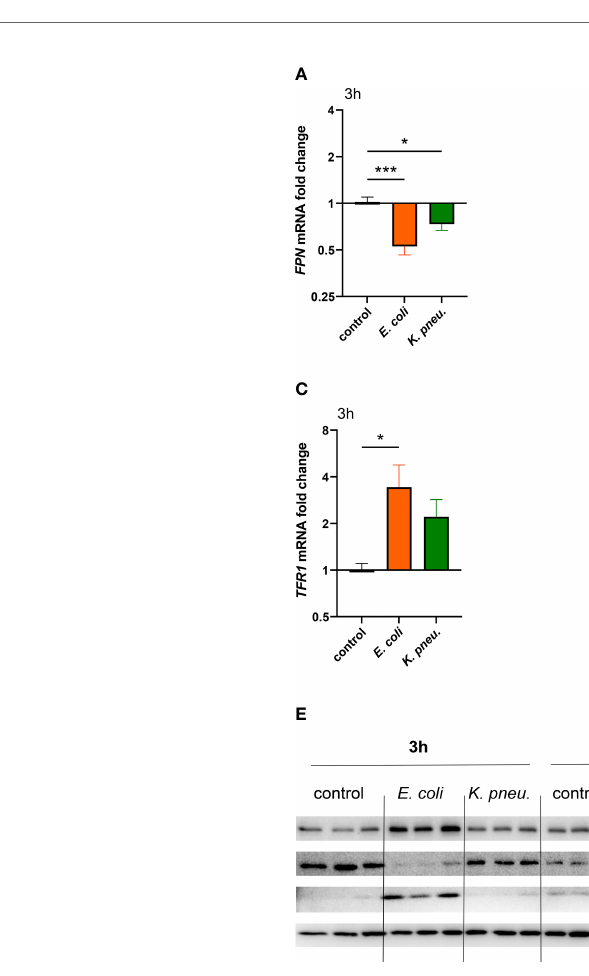
FIGURE 2 | Differential expression of FPN (A, B) and TFR1 (C, D) mRNA in infected A549 cells. A549 cells were infected for 2h with E. coli or K. pneumoniae at MOI of 10, subsequently washed thoroughly and harvested after 3h (A – C) or 6h (B – D) of intracellular infection. Data are shown as mean ± SEM of 3 separate experiments.Western blot of iron transport proteins in infected A549 cells (E) . A549 cells were infected for 2h with E. coli or K. pneumoniae at MOI of 10, subsequently washed thoroughly and harvested after 3h (A, C) or 6h (B, D) of intracellular infection. Representative image of three separate experiments.* denotes p<0.05, ** denotes p<0.01, *** denotes p<0.001 for post-hoc statistical testing. K. pneu., K, pneumoniae ; TFR1, transferrin-receptor-1; FPN, ferroportin; FT, ferritin; ACTB, b